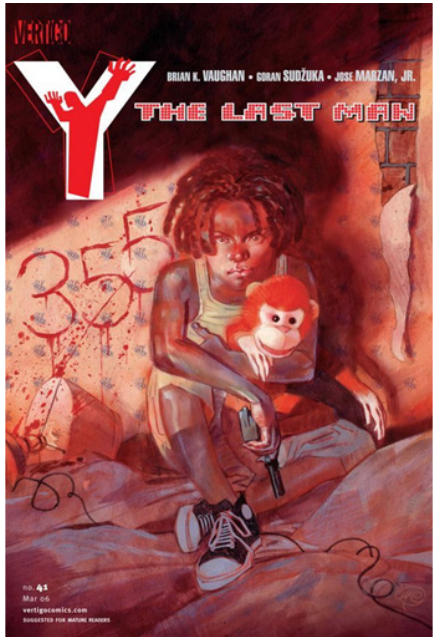
Figure 4. Y: The Last Man: “Buttons,” Vol. 7, No. 41 (2006), cover by Massimo